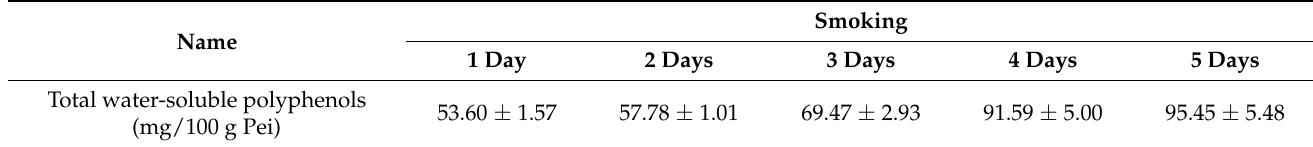
Table 2. Changes in total water-soluble polyphenols during the smoking process of Shanxi aged